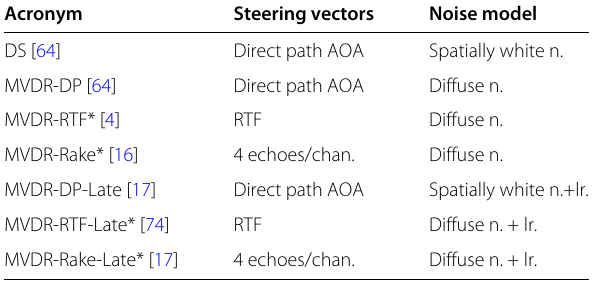
Table 6 Summary of the considered